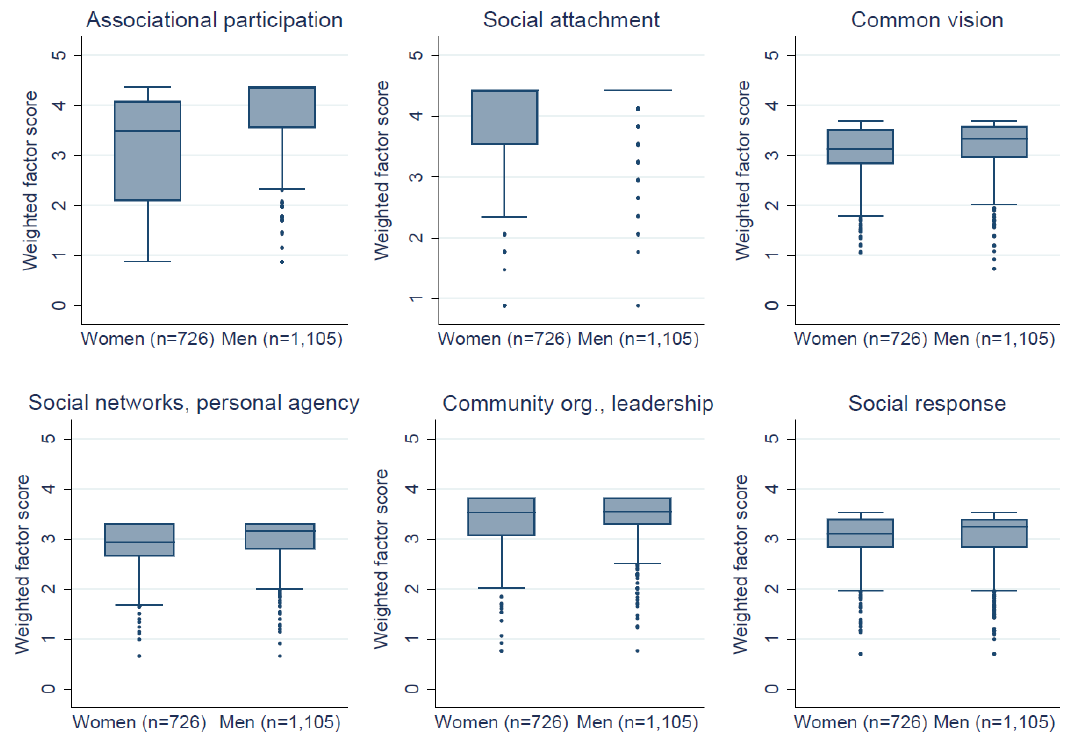
Figure 1. Collective efficacy factor scores (weighted), by respondent gender. Factor scores are visualised as box plots, which depict the distribution of the data through quartiles. The boxes represent the inter-quartile range (i.e., 25% and 75% quartiles comprise the outer edges of the boxes, while the median is indicated by the line inside the box). The lines that extend vertically from either side of the box (i.e., whiskers) indicate the variability of the data outside the upper and lower quartiles. Outliers are plotted as individual points.